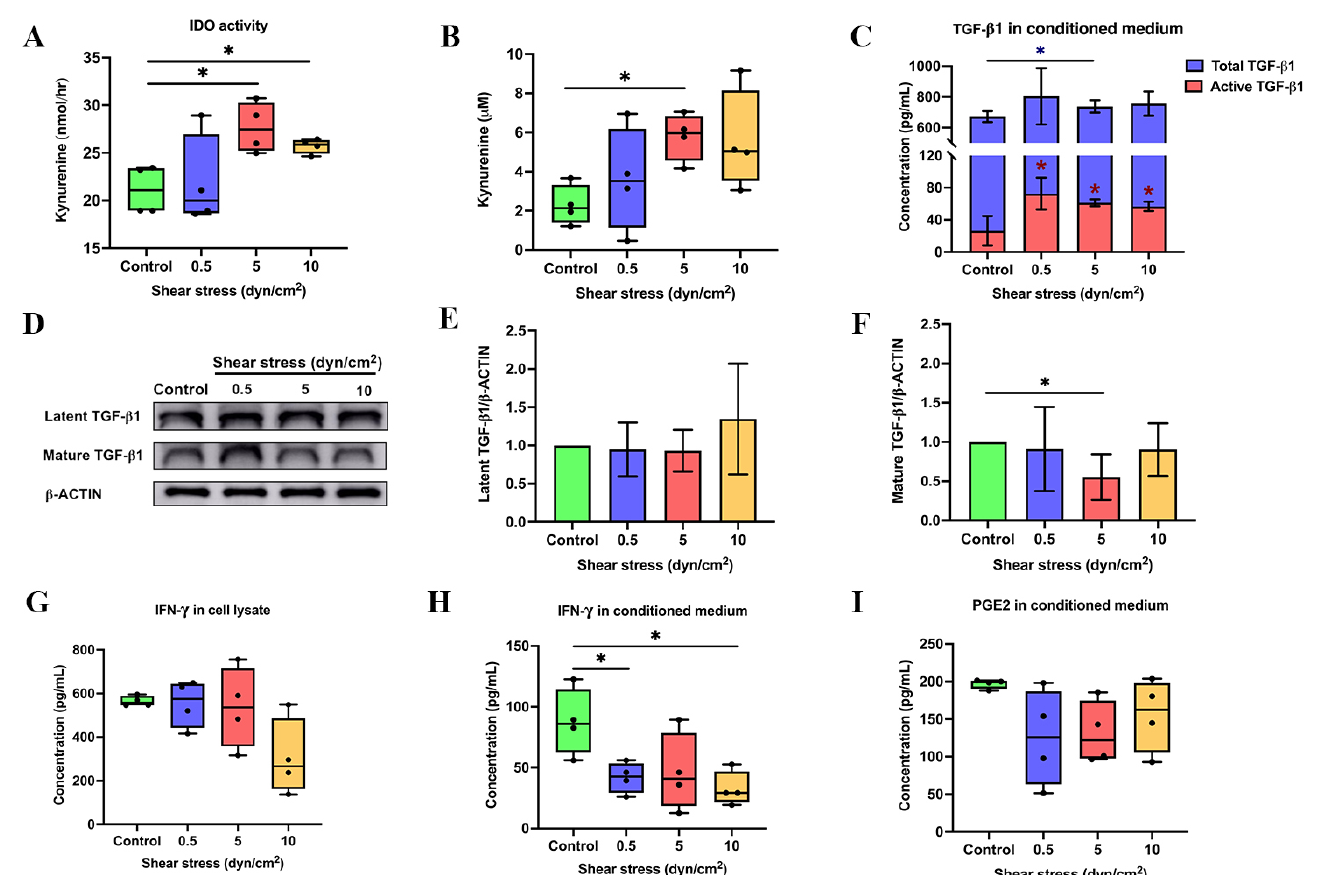
Figure 2. Protein expression of immunosuppressive regulators in shear stress-induced hPDLSCs. Shear stress promoted IDO activity ( A ) and the kynurenine product ( B ) in hPDLSCs. Shear stress increased the secretion of active TGF- β 1 in PDLSC-derived conditioned medium ( C ). TGF- β 1 protein expression in hPDLSCs was determined by Western blot analysis ( D ). The quantitative analysis of Western blot band intensity of latent TGF- β 1( E ) and active TGF- β 1 ( F ). The concentration of IFN- γ in cell lysate ( G ) and conditioned medium ( H ) and the amount of COX2-independent PGE2 were determined by ELISA assay ( I ). * p < 0.05 vs. control